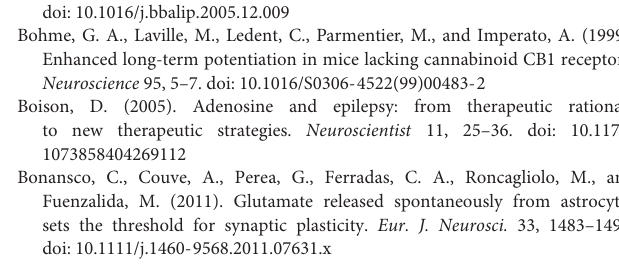
FIGURE S1 | No appreciable differences between data obtained in males or females were detected. Values are represented as the mean ± SEM. The number of experiments in each condition is indicated in the bars. No significant differences between males and females were found, F ( 11 , 102 ) = 7.2, t -values – Control WT:Control WT male = 0.9, Control WT:Control WT female = 0.5, AM251 WT:AM251 WT male = 0.9, AM251 WT:AM251 WT male = 0.6,